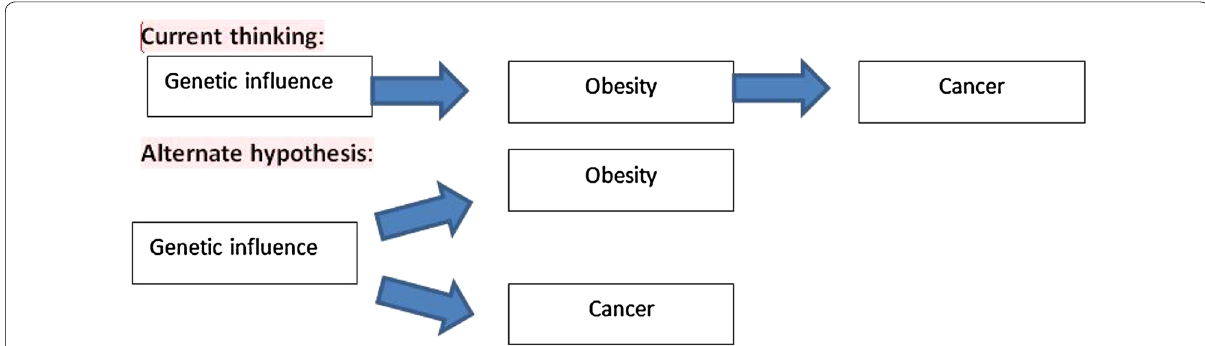
Fig. 1 Relation between obesity and cancers: an alternate